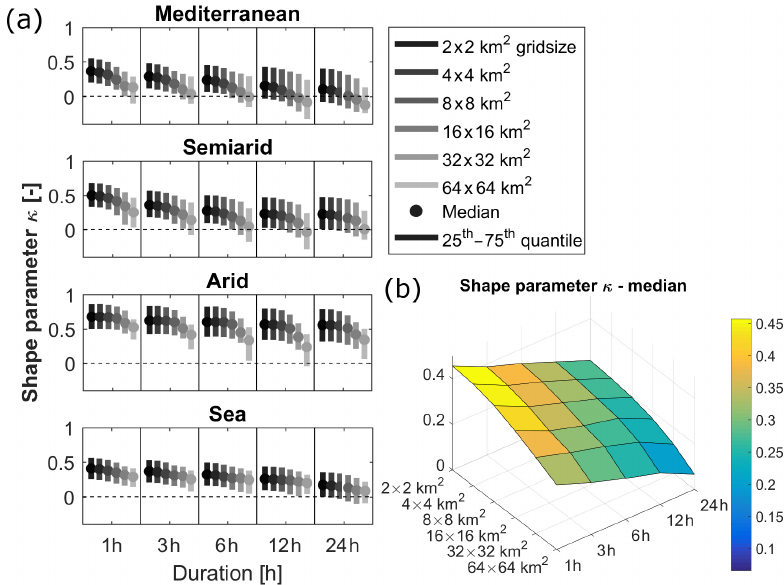
Figure 3. (a) Distribution (median and 25–75th quantiles) of the shape parameter derived aggregating radar estimates on grid sizes increasing from 2km × 2km to 64km × 64km. (b) Median of the shape parameters (all climates) derived aggregating radar estimates as a function of the spatial and of the temporal aggregation